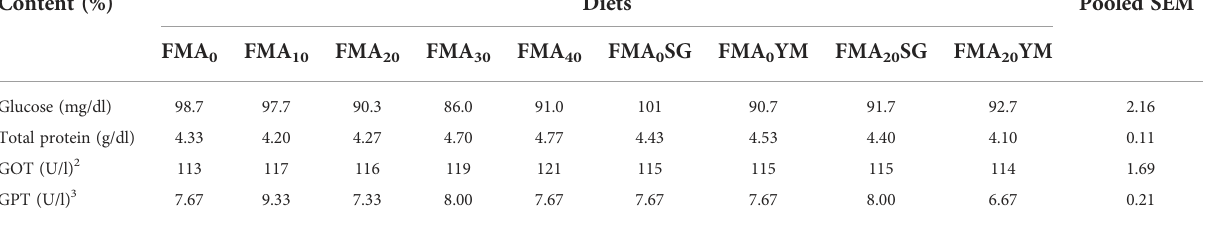
TABLE 5 Serum biochemical parameters in juvenile Japanese eel the experimental diets for 8 weeks 1 . Content (%) Diets